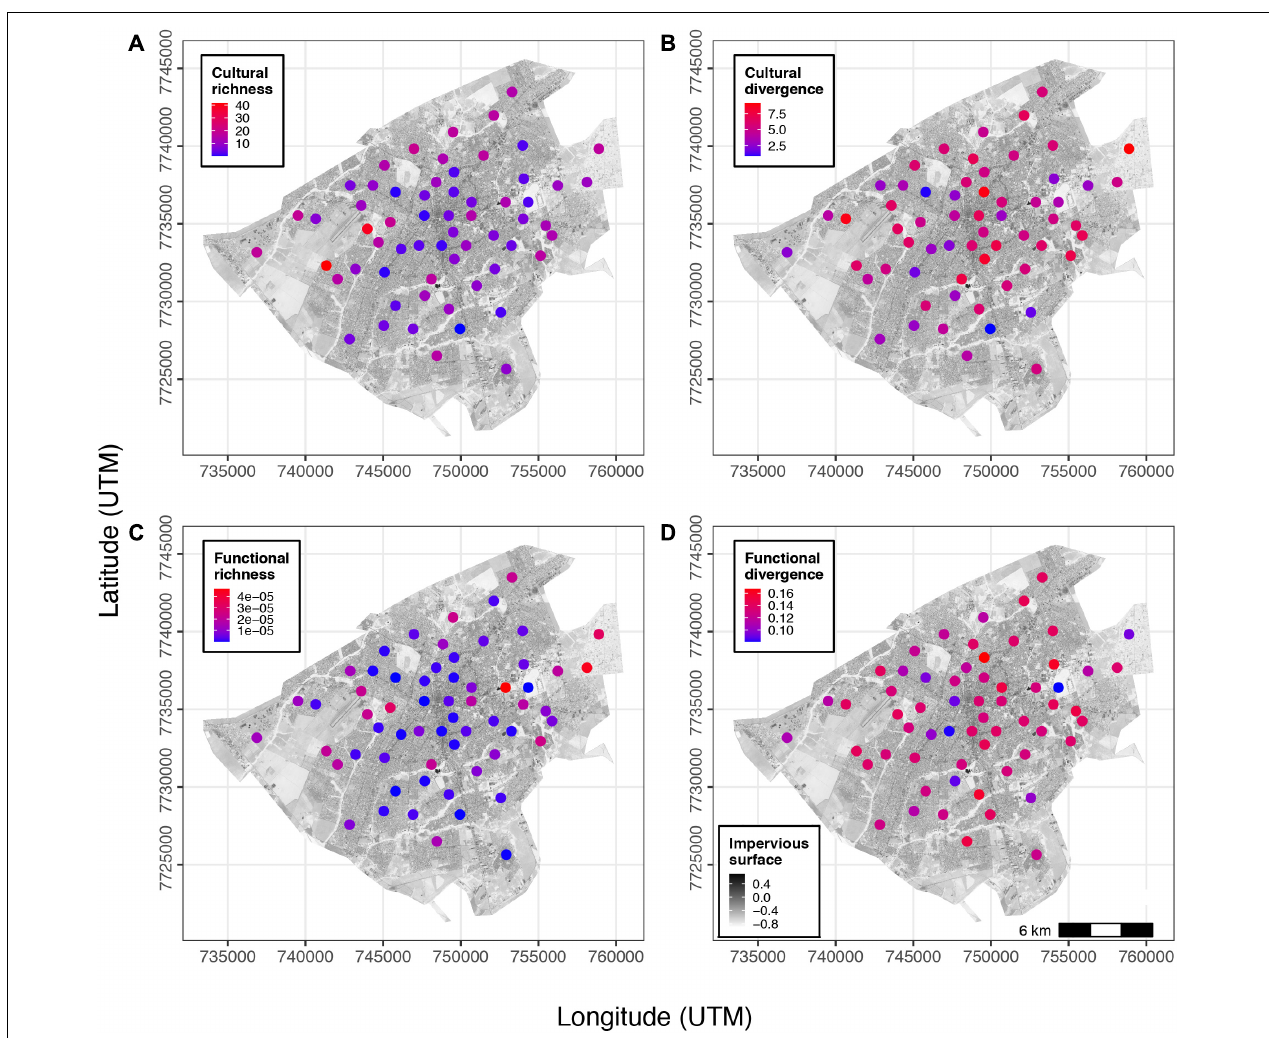
FIGURE 2 | Spatial distribution of cultural (A) and functional richness (B) , and cultural (C) and functional divergence (D) along the gradient of impervious surface cover in Campo Grande, central